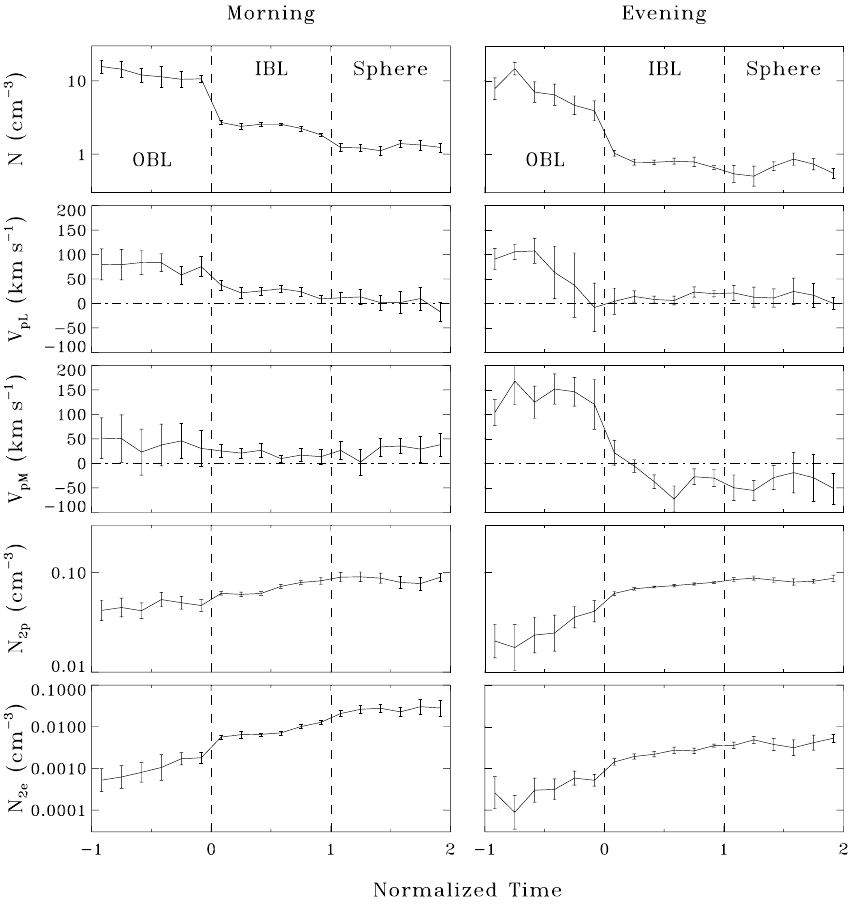
Fig. 7. Superposed epoch analysis of the components V pL , V pM of the proton bulk velocity the total plasma density, N , the partial density, N 2 p , of protons above 8keV, and the partial density, N 2 e , of electrons above 1.8keV across the inner boundary layer. The sign of V pL is reversed for crossings at south- ern latitudes and the sign of V pM is re- versed for crossings duskward of local noon. The left panels display data from 13 crossings dawnward of local noon and the right panels display data from 9 crossings duskward of local noon. Nor- malized time ˘ t = 0 corresponds to the interface between the OBL and the IBL and normalized time ˘ t = 1 corresponds to the inner edge of the boundary layer. Vertical error bars indicate the standard deviation of the average of each param-